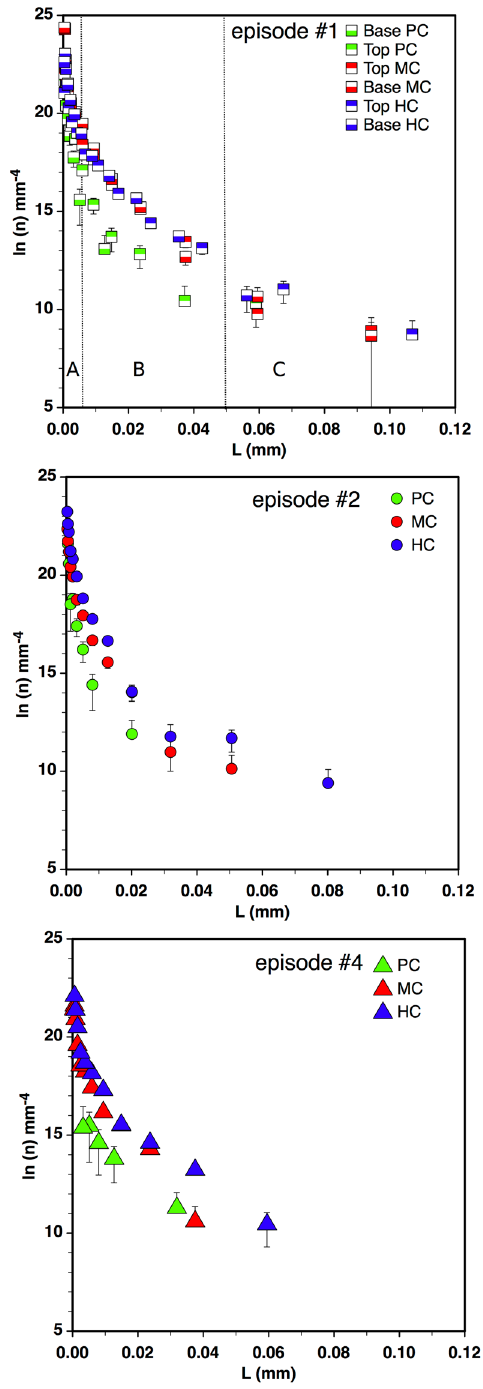
Figure 4. Crystal size distribution measured in clasts from different eruptive episodes (HC = highly crystalline, MC = moderately crystalline; PC = poorly crystalline). Error bars show standard deviations in crystal populations calculated according to 60 . The vertical line in the upper diagram delimits size